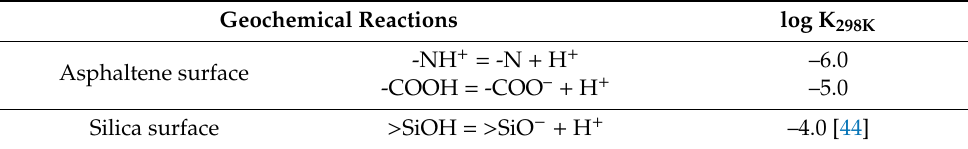
Figure 5. Schematic diagram of surface species in asphaltene-brine-silica system. Table 2. Surface complexation modelling parameters [44].